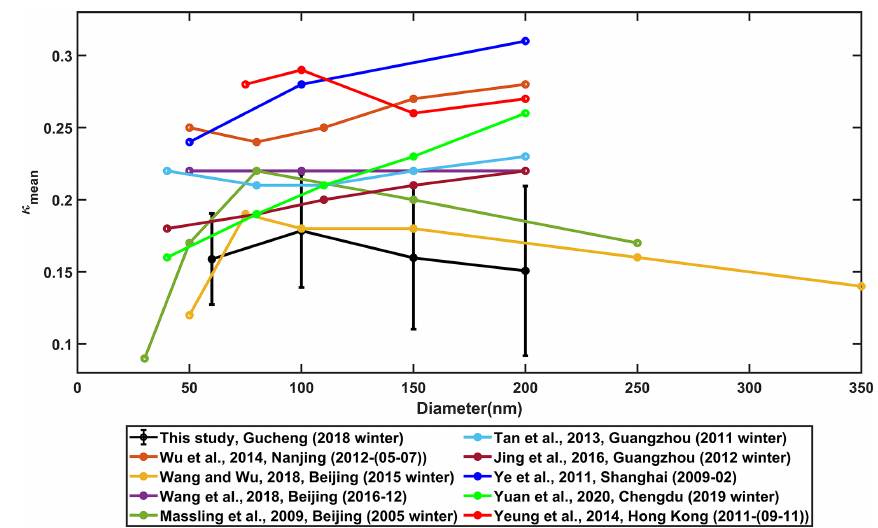
Figure 3. The ensemble mean hygroscopicity parameter ( κ mean ) values for ambient aerosols of different cities in China.